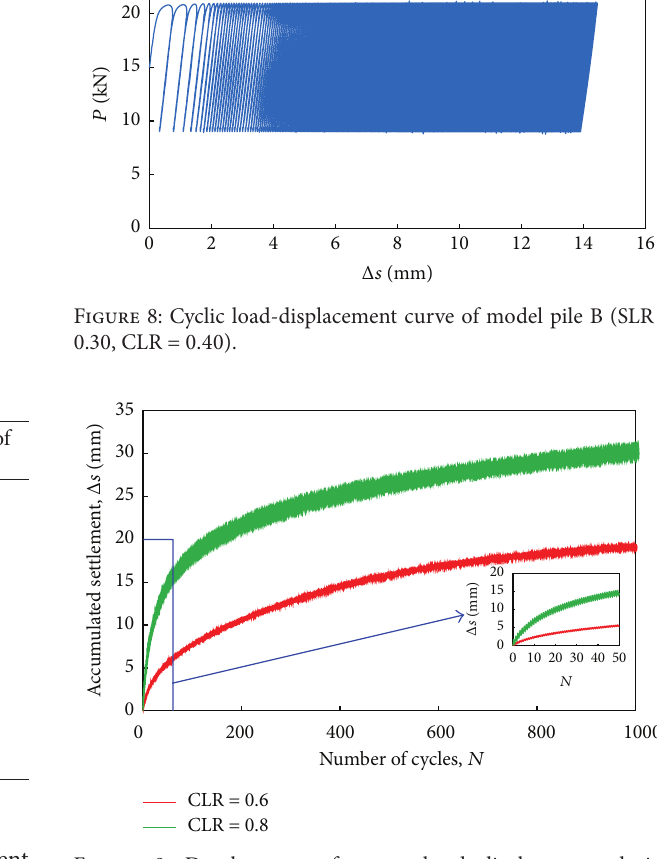
Figure 9: Development of accumulated displacement during dynamic loading tests (SLR =